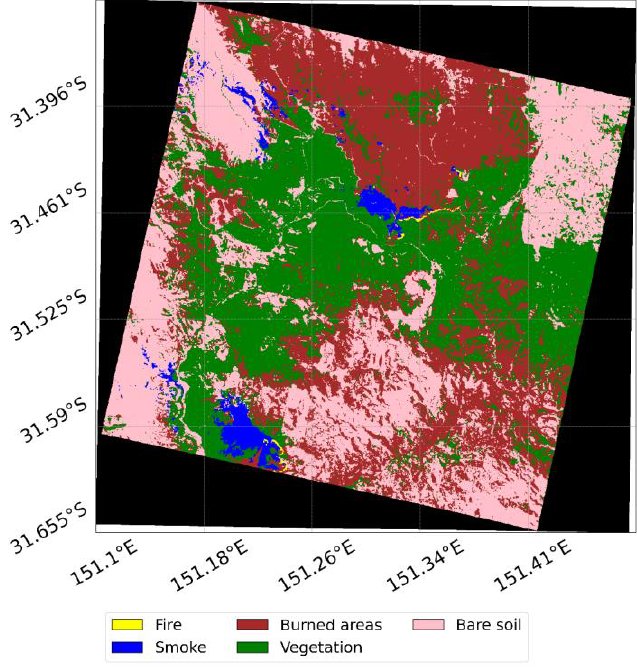
Figure 11. Segmentation map obtained from the trained model.